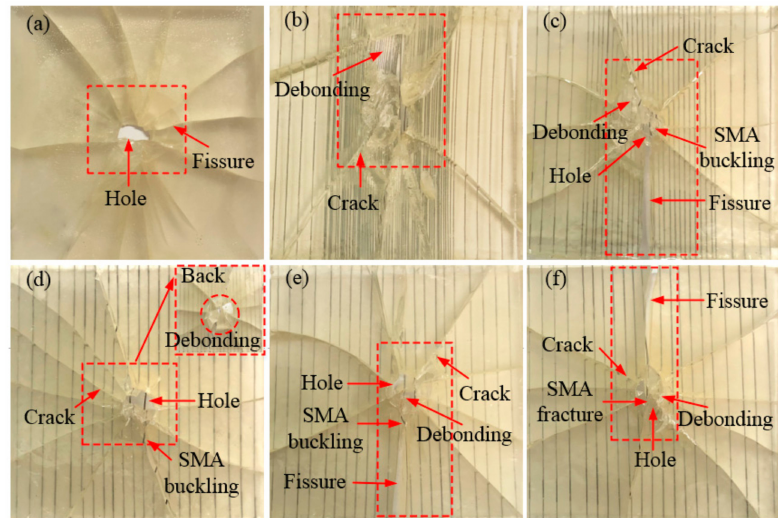
Figure 6. The failure modes diagrams of spacing specimens with different SMA layup spacing under 14 J of energy: ( a ) indicates the pure resin-matrix test specimen; ( b – f ) indicate the SMA reinforced resin-matrix test specimens with SMA layup spacing of 1, 2, 3, 4, 5 mm, respectively.